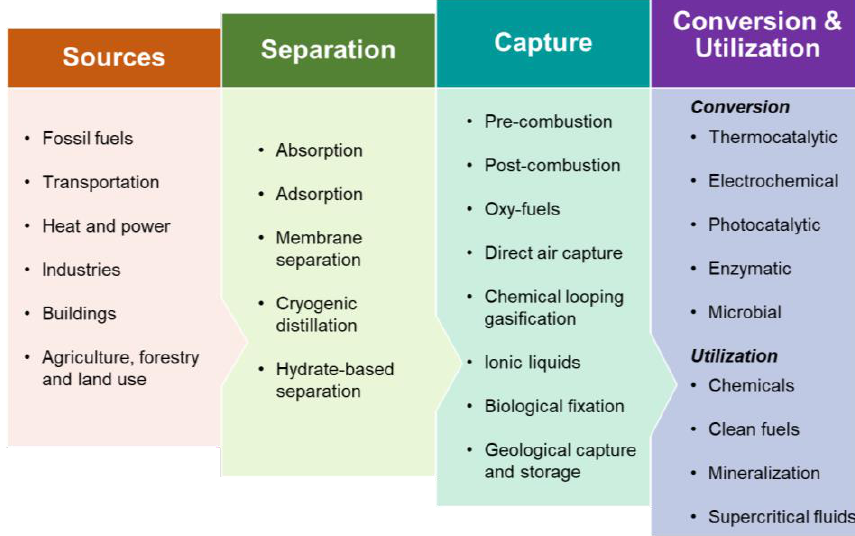
Figure 5. Common routes for CO 2 separation, capture and utilization.